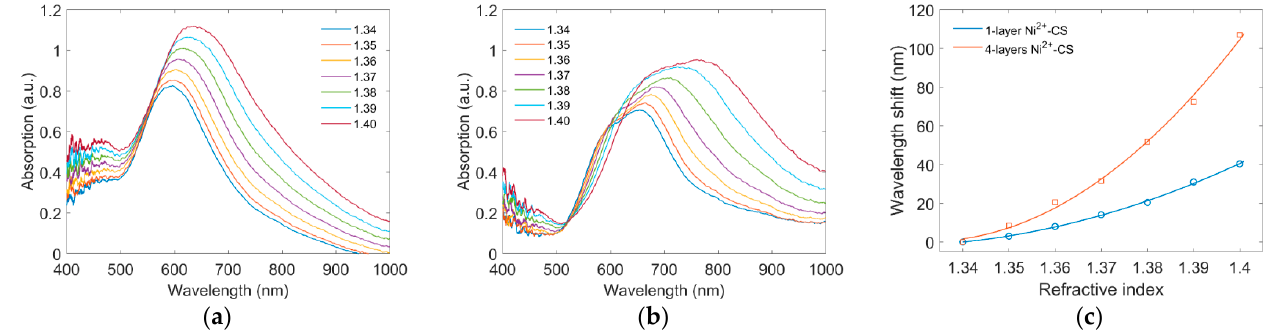
Figure 6. Refractive index sensing of the LSPR sensor with difference thickness of the Ni 2+ –CS gel. Absorption spectra of the LSPR sensor with ( a ) one layer of Ni 2+ –CS gel and ( b ) four layers of Ni 2+ –CS gel. ( c ) Comparison of the wavelength shift.